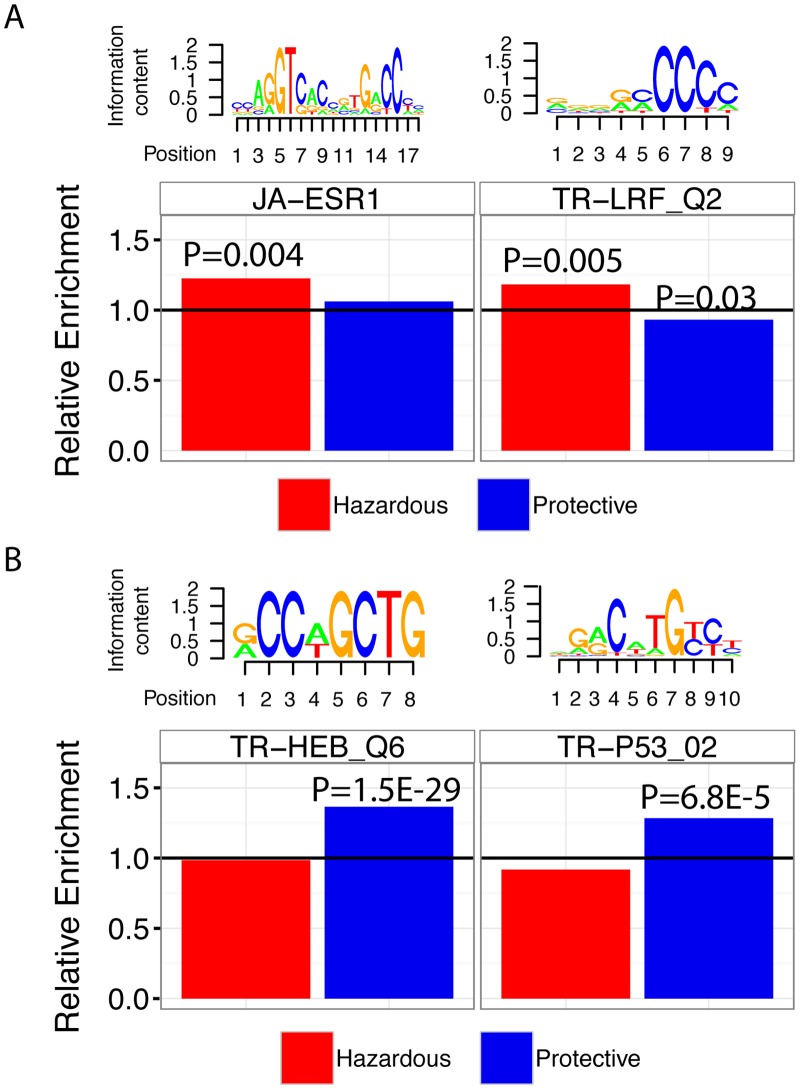
TF binding motifs enriched in survival-associated CpG regions in primary breast cancer samples.
A) Relative enrichment levels of JA-ESR1 and TR-LRF_Q2 in all breast cancer samples. B) Relative enrichment levels of TR-HEB_Q6 and TR-P53_02 in all breast cancer samples. Motif logos are provided above each panel to show information content of each motif.